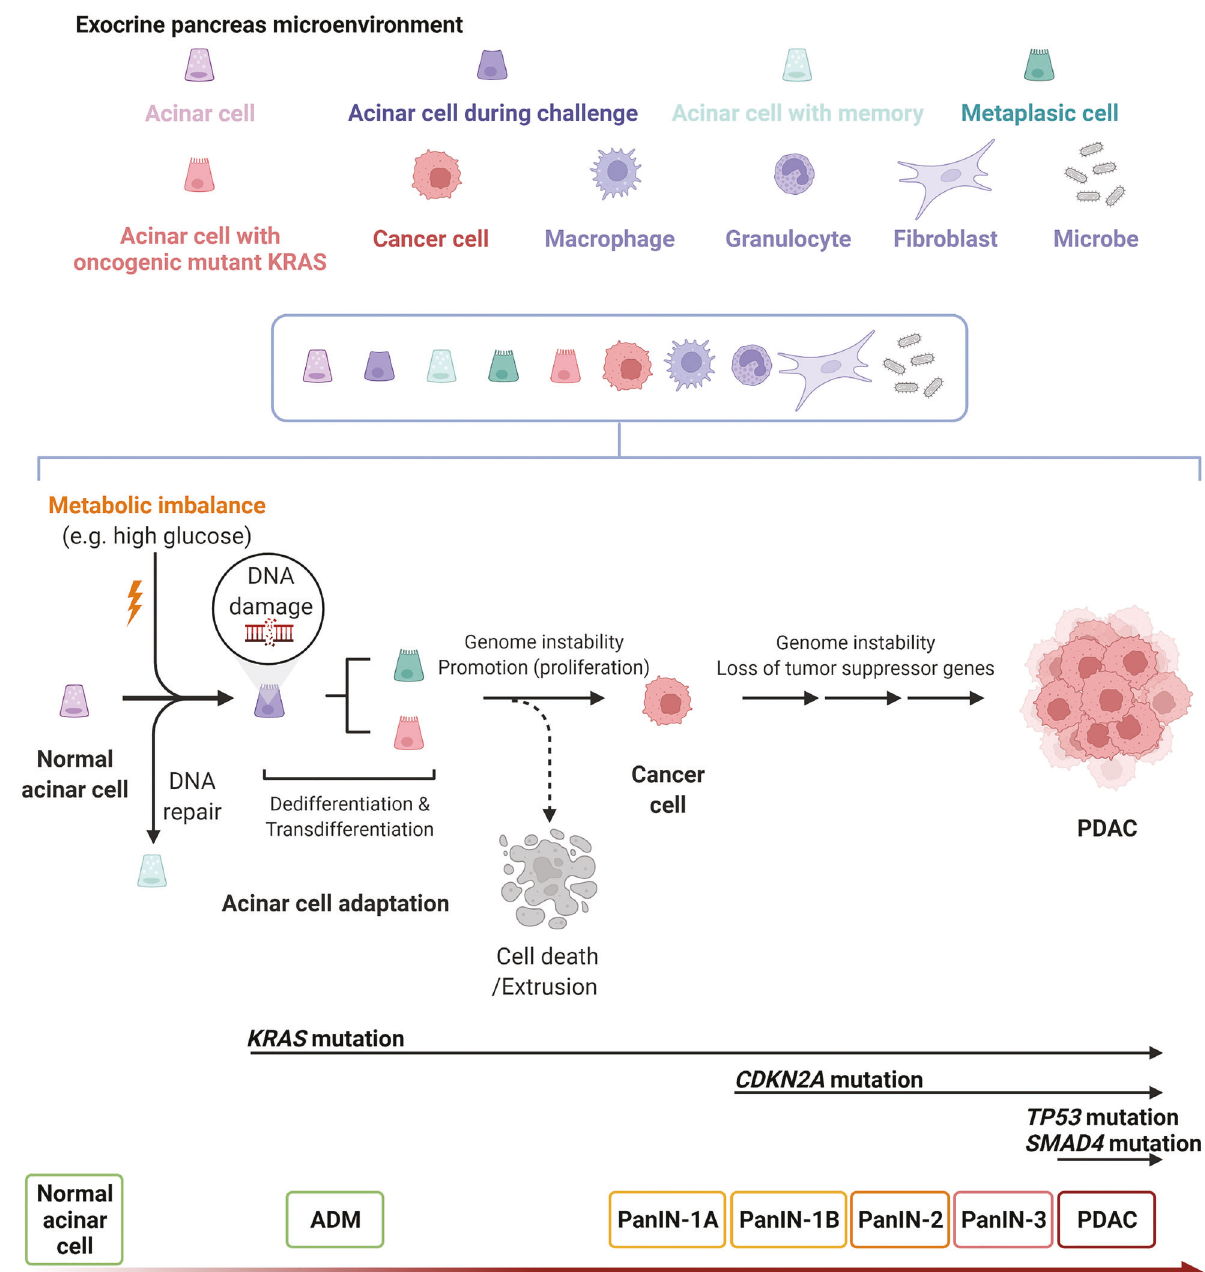
Fig. 4 Normal acinar cells undergo sustained transcriptional and epigenetic reprogramming after challenging metabolic imbalance (e.g., high glucose). In response to DNA damage, cells may activate cell cycle checkpoints, process epigenetic and transcriptional programs or DNA repair (with epithelial memory), or undergo apoptosis when the damage is severe. Cells with adapted DNA mutation (e.g., oncogenic KRAS mutation) survived apoptosis and extrusion, with histologic and genetic progression, may transform into cancer cells and further grow as pancreatic ductal adenocarcinoma (PDAC) in adaptive to exocrine microenvironment-induced genome instability. Histologically, PDAC stems from microscopic abnormal acinar-to-ductal metaplasia (ADM) and pancreatic intraepithelial neoplasias (PanINs) of grades I – III to PDAC with increasing disorganization and nuclear abnormalities. High percentages of patients with PDAC carry somatic mutations, including KRAS proto- oncogene, GTPase ( KRAS ; ~95%) cyclin-dependent kinase inhibitor 2A ( CDKN2A ; ~90%), tumor protein 53 ( TP53 ; ~70%), and SMAD family member 4 ( SMAD4 ; ~55%). The pancreatic exocrine microenvironment is composed of exocrine cells at different stages, fi broblasts, immune cells, and microbes. The role of these microenvironmental components in adaptation, cancer initiation and progression remains to be elucidated. The graph was created with KRAS -mutated cells prevail in competition under high-fat- associated with long-term patient survival [102]. Altered gut induced in fl ammation microbiome composition and changes in host processing of Not all pancreatic cells develop PanIN in genetically engineered bacteria-derived metabolites may imply the link between diabetes mice with the Kras G12D mutation, suggesting that additional and PDAC initiation and progression with geographical, racial, dietary, and lifestyle-related differences [104]. factors are needed for the initial transformation. Figure 4